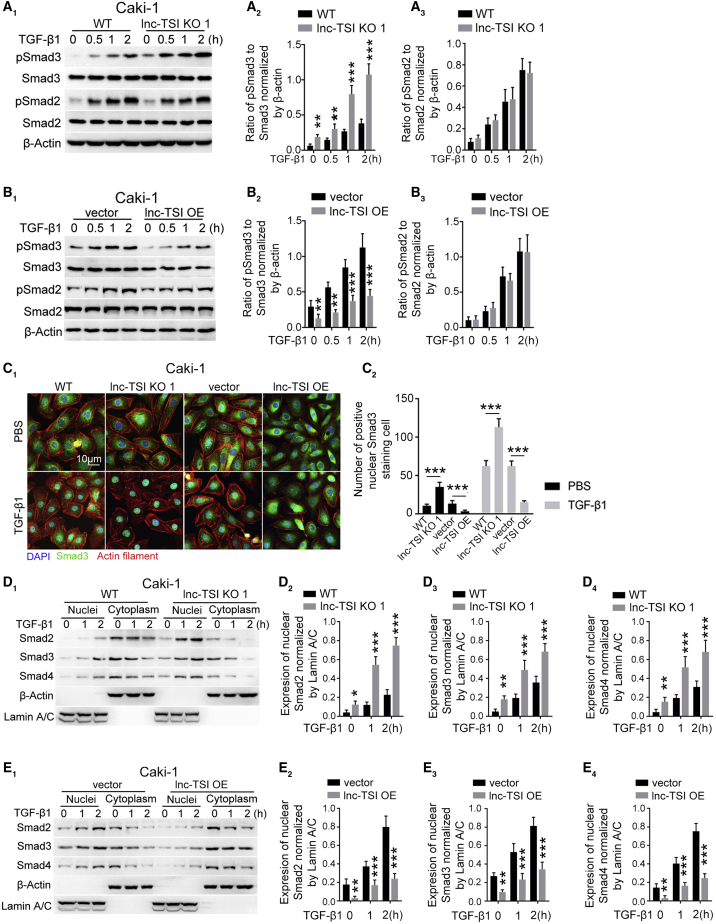
lnc-TSI Inhibited TGF-β1-Induced Smad3 Phosphorylation and nu. Translocation of the Smads Complex in Caki-1 Cells(A) Western blot showed that knocking out lnc-TSI promoted Smad3, but not Smad2, phosphorylation in Caki-1 cells in the presence or absence of exogenous TGF-β1 (A1). The data analysis results are shown in (A2) and (A3). (B) Western blot demonstrated that the overexpression of lnc-TSI inhibited Smad3, but not Smad2, phosphorylation in Caki-1 cells in the presence or absence of exogenous 10 ng/mL of TGF-β1 (B1). The data analysis results are shown in (B2) and (B3). (C) Immunofluorescence confocal images showed that knocking out lnc-TSI enhanced Smad3 nu. translocation in Caki-1 cells while overexpressing lnc-TSI inhibited Smad3 nu. translocation in the presence or absence of exogenous 10 ng/mL of TGF-β1 for 1 h (C1). The quantitative data of positive nu. Smad3 staining cells are shown in (C2). (D) Western blot in nucleus and cyto. of Caki-1 cells demonstrated that knockout of lnc-TSI promoted the nu. translocation of Smads in Caki-1 cells incubated with or without exogenous TGF-β1 (D1). β-Actin and lamin A/C were separately applied as the loading control for the cyto. or nucleus. The data analysis results are shown in (D2), (D3), and (D4). (E) Western blot demonstrated that the overexpression of lnc-TSI inhibited the nu. translocation of Smads in Caki-1 cells incubated with or without TGF-β1 (E1). The data analysis results are shown in (E2), (E3), and (E4). Data are expressed as means ± SD of three independent experiments. ∗p < 0.05, ∗∗p < 0.01, ∗∗∗p < 0.001.